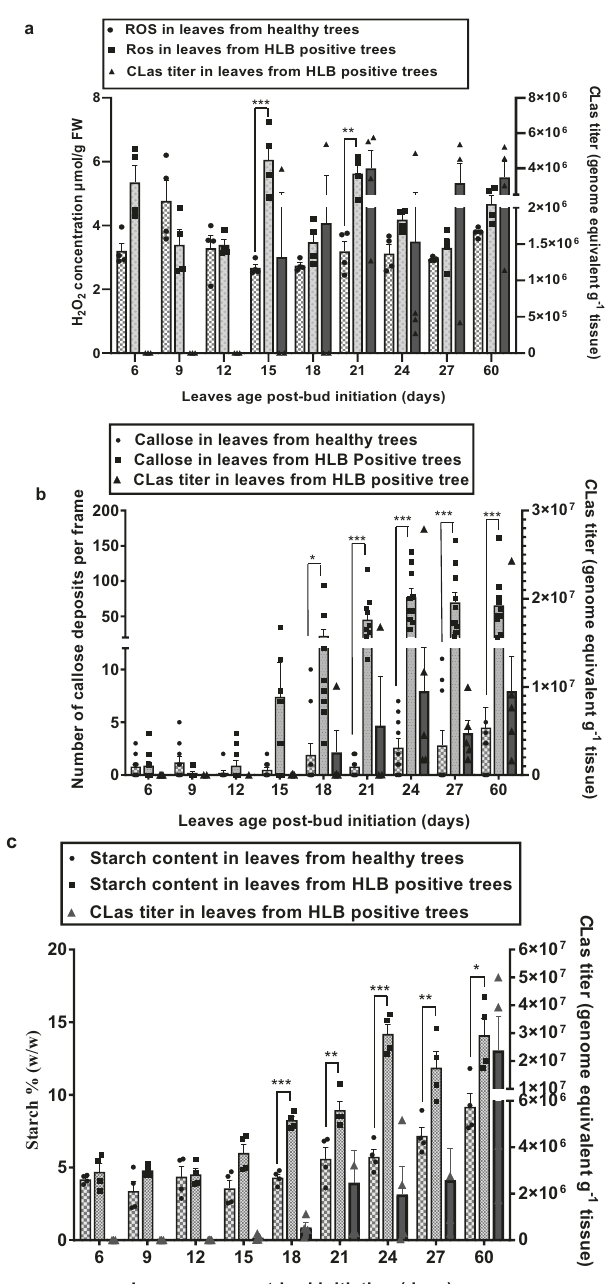
Fig. 1 CLas infection causes ROS production, callose deposition, and starch accumulation in young citrus leaves. a Quanti fi cation of H 2 O 2 in young leaves of 2-year-old HLB positive and healthy C. sinensis “ Valencia ” trees. Data shown are mean ± SEM, n = 4. b Quanti fi cation of callose depositions of young leaves by staining with aniline blue and observed under an epi fl uorescence microscope. Data shown are mean ± SEM, n = 10. Callose depositions were counted from ten leaves from fi ve trees. c Starch content in young fl ush. Data shown are mean ± SEM, n = 4. HLB positive and healthy 2-year-old C. sinensis “ Valencia ” trees were trimmed to trigger young fl ush in the greenhouse. qPCR was conducted to quantify CLas titers in newly emerged leaves at different time points after bud initiation. Experiments were repeated twice with similar results. *, **, and *** indicate p value < 0.05, 0.01, and 0.001, respectively, compared with healthy young leaves and calculated using two-tailed Student ’ s t test. Source data are provided as a Source Data fi